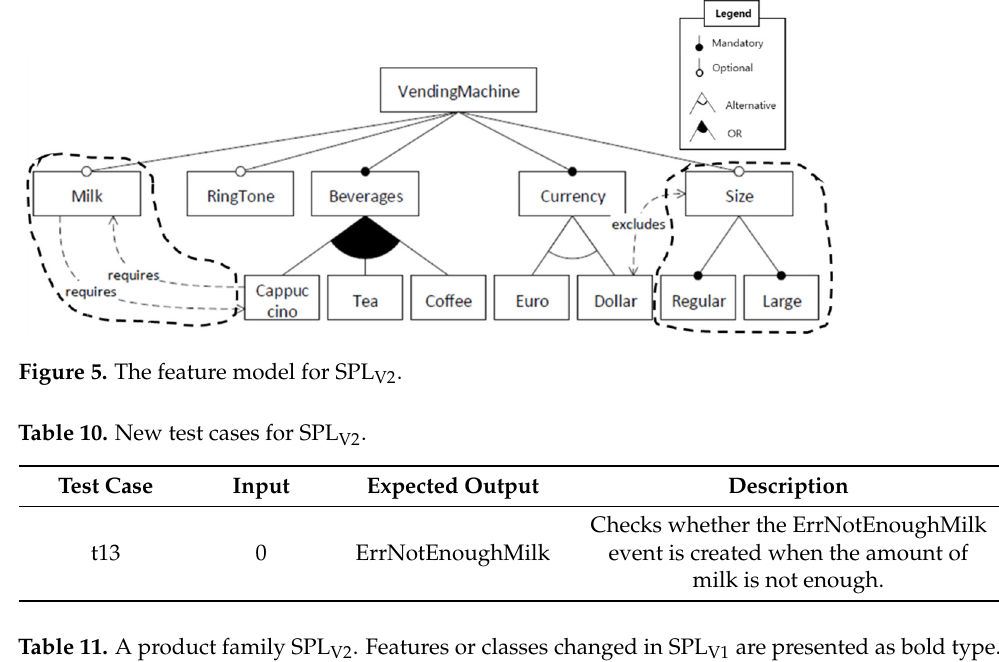
Table 11. A product family SPL V2 . Features or classes changed in SPL V1 are presented as bold